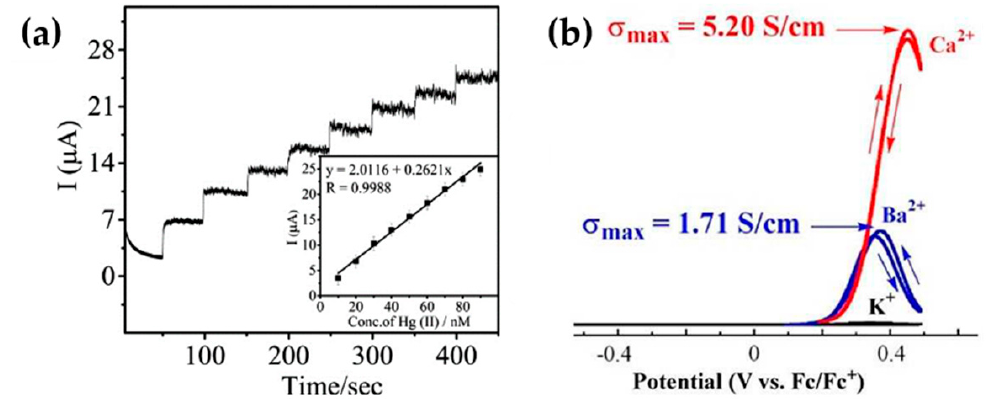
Figure 6. ( a ) Amperometric curve for different Hg 2+ concentrations at a GCE/poly(CoTABImPc) in a 0.1 M PBS pH 7.0, applied potential 0.18 V. Inset: Plot for current response as function of the Hg 2+ concentration. Adapted from reference [97]. ( b ) In-situ conductivity measurements for poly-calix [4] arene-bithiophene films with K + , Ba 2+ , and Ca 2+ ions in a 5 µ m interdigitated microelectrode at a v = 5 mV/s with a ∆ V in the WE = 40 mV. Adapted from reference [100].